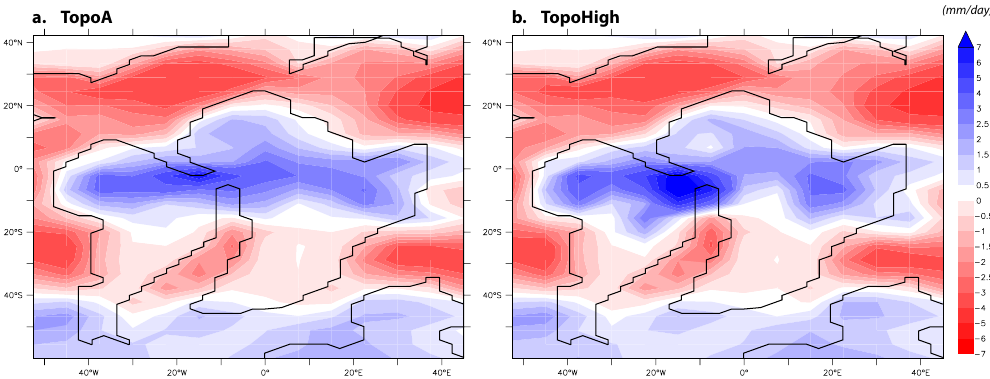
Fig. 4. Annual P − E (precipitation minus evaporation) for the TopoA and the TopoHigh simulations. Positive blue (negative red) colors represent precipitation (evaporation)